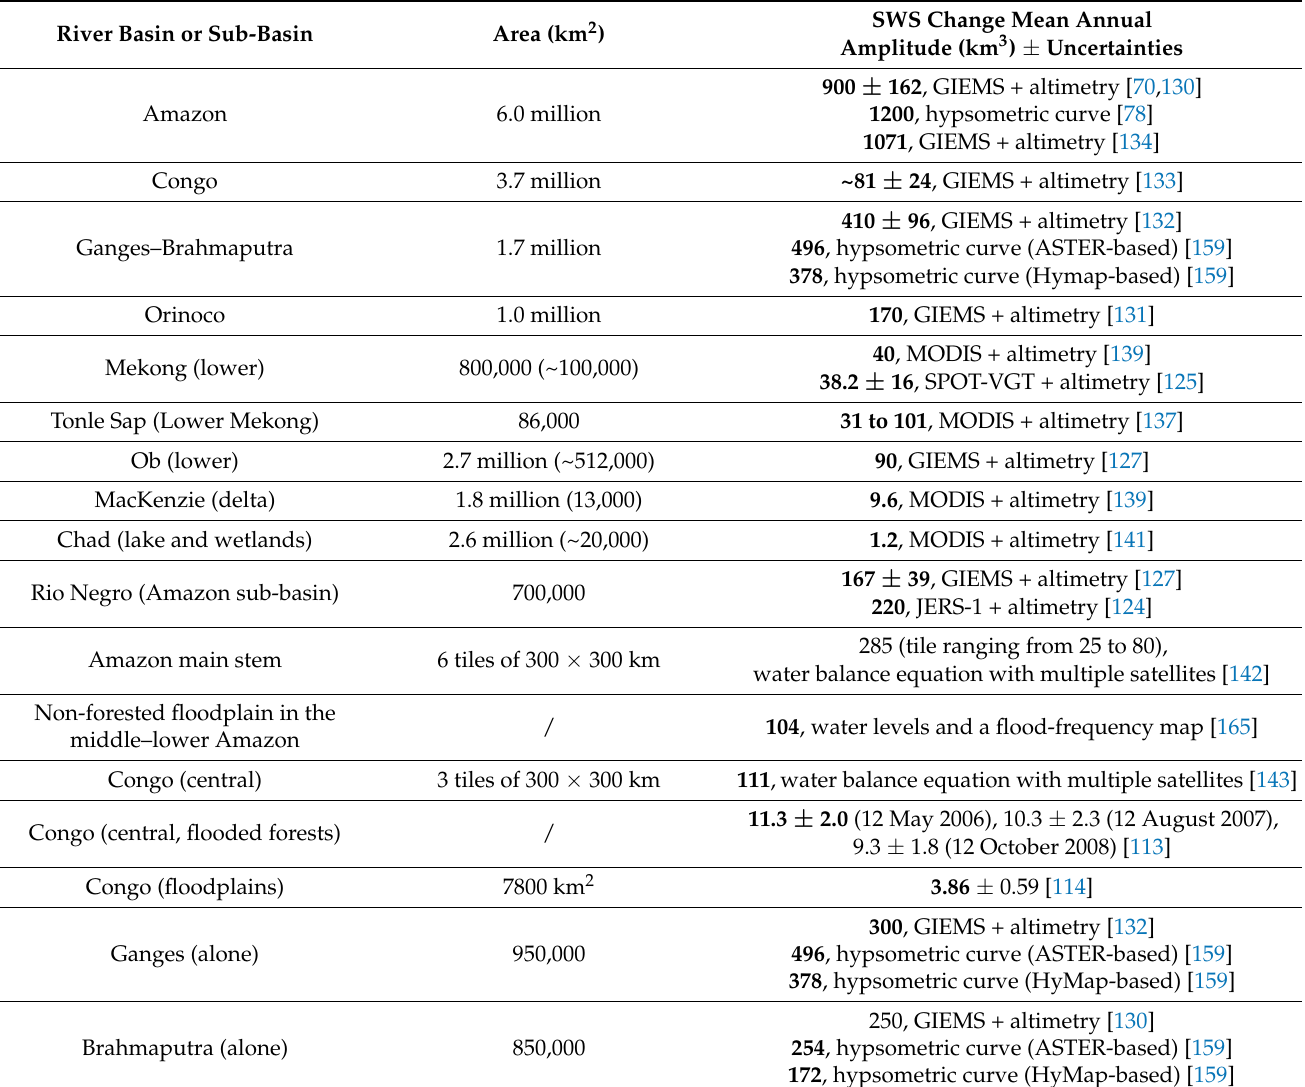
Table 3. Mean annual amplitudes of SWS variations estimated across studies for several large river basins. The first column is the name of the river basin. The second column is the total drainage area of the basin, and the value in brackets is the area considered for the cited study. The third column provides the estimates of mean annual amplitudes of SWS variations in km 3 , along with uncertainties when available. The method used is provided along with the references of the study in